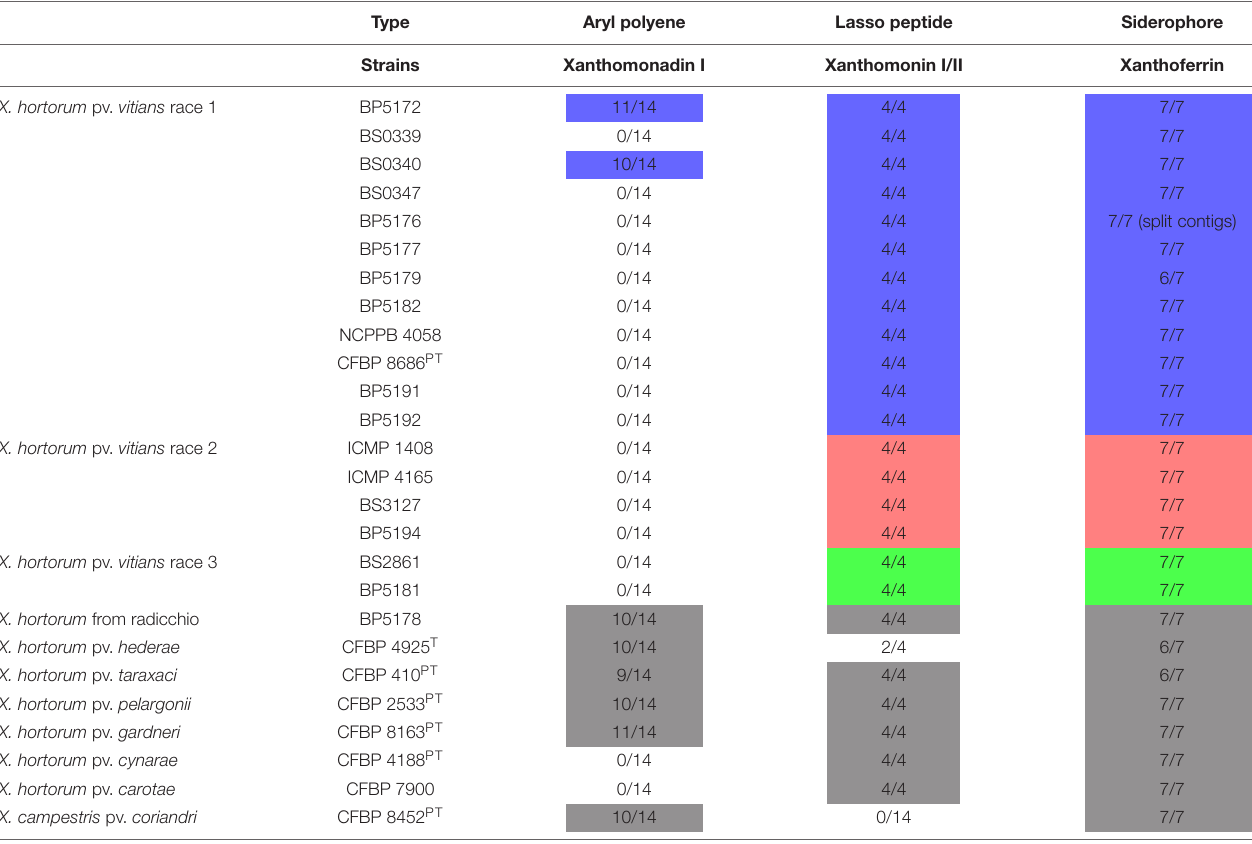
TABLE 4 | Predicted secondary metabolite gene